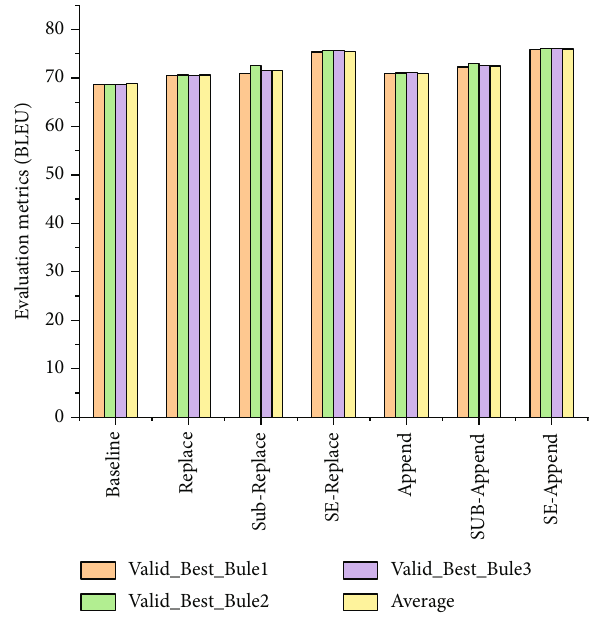
Figure 3: Validation set translation